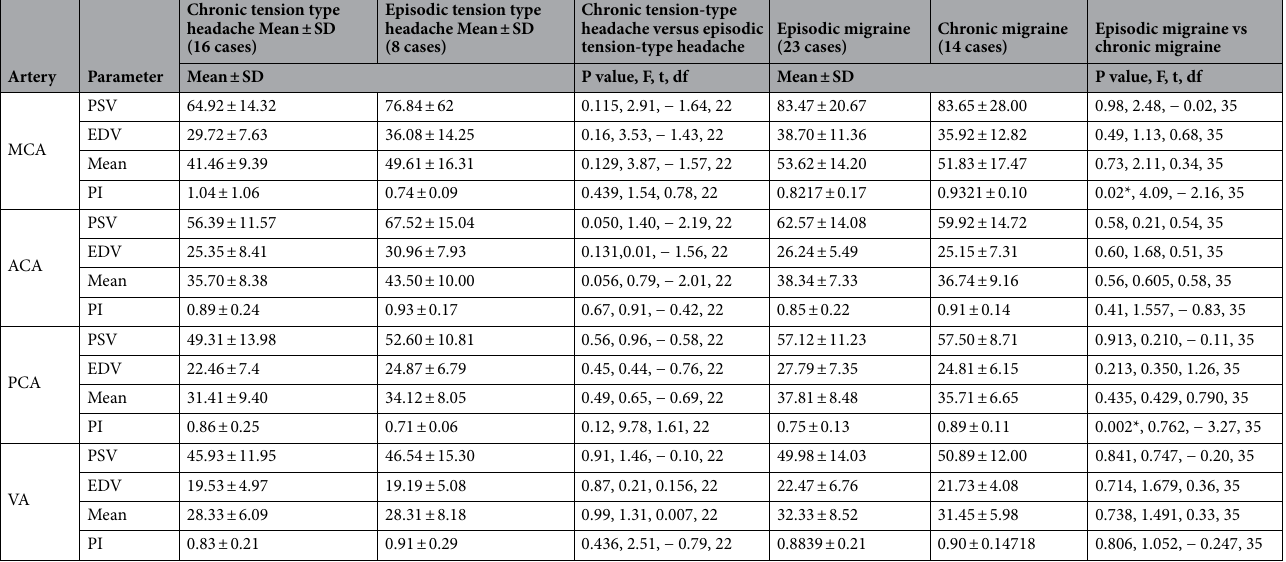
Table 2. Differences in the Resting duplex parameters of anterior and posterior cerebral circulations between different subgroups of each type of headache (chronic tension type versus episodic tension type headache) and subgroups of migraine (chronic migraine versus episodic migraine). MCA middle cerebral artery, ACA anterior cerebral artery, PCA posterior cerebral artery, VB vertebral artery, PSV Peak Systolic